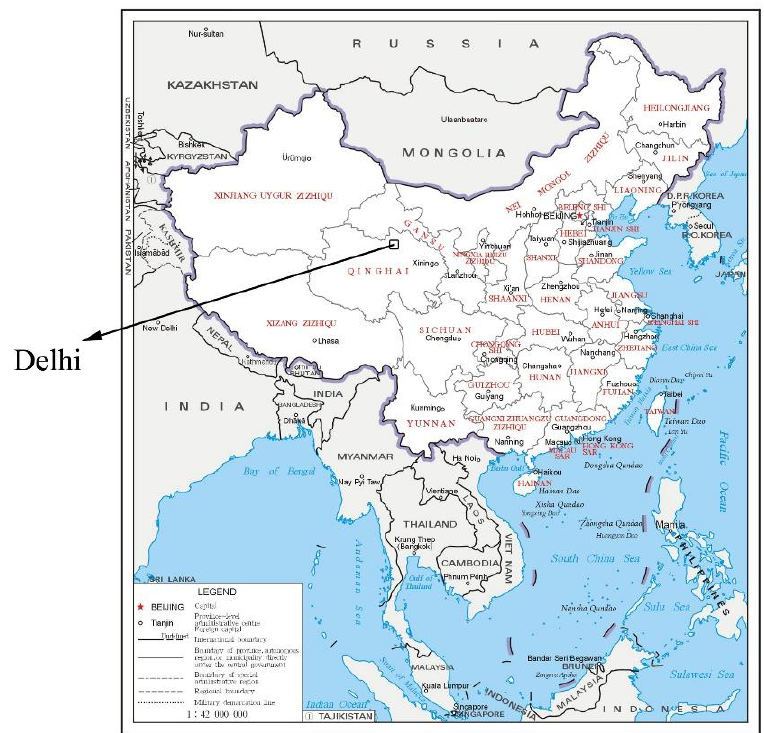
Figure 1. Map of China showing the study area.